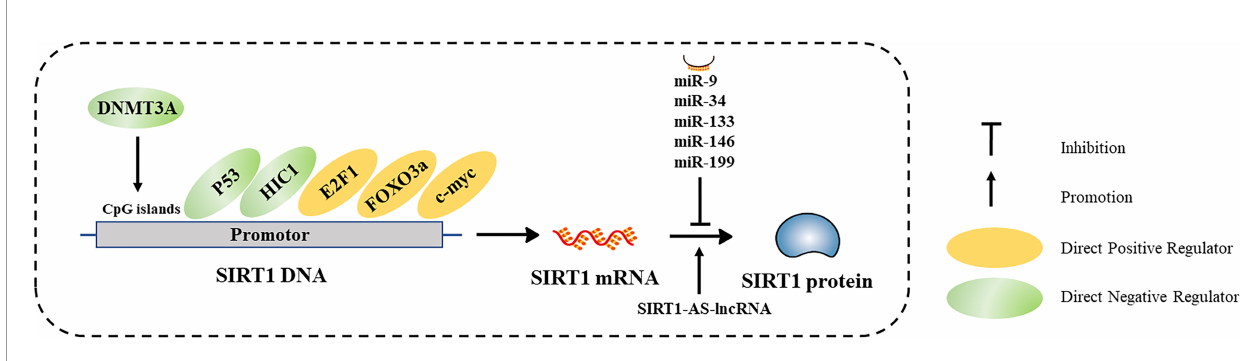
FIGURE 3 | Characterized mechanisms that regulate SIRT1 expression, including transcriptional regulation and